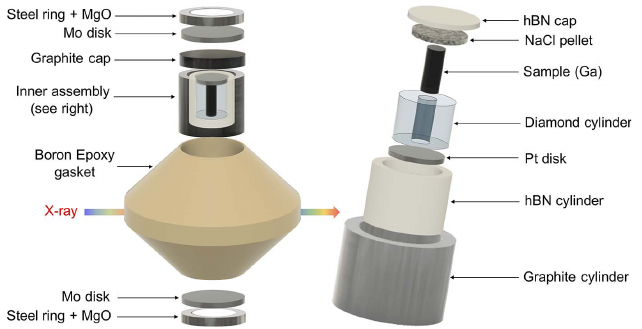
Figure 2 Schematic view of the sample assembly. (Right) The sample is contained in a diamond cylinder of internal and external diameters 0.5 and 1.5 mm, respectively. The capsule is sealed by a platinum disk and a sodium chloride pellet and encapsulated in a hexagonal boron nitride cylinder acting as the pressure-transmitting medium. It is then placed in a graphite heater. (Left) The assembly is placed in a boron epoxy gasket. A molybdenum disk and ring ensure optimal electrical contact for the generation of high temperature. Finally, the assembly is placed in a PEEK ring to avoid extrusion (not